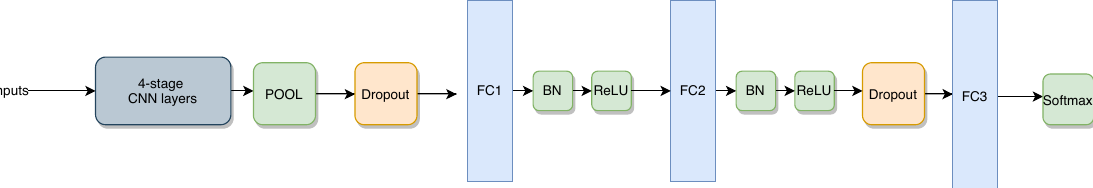
Figure 6. Block diagram of the Convolutional Neural Network (CNN) multi-label classifier. It consists of a CNN encoder to learn feature representation from the input feature, and the output layer to produce the predicted